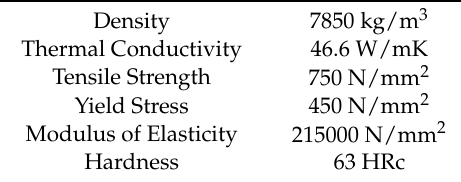
Table 2. EN31 alloy steel physical properties.